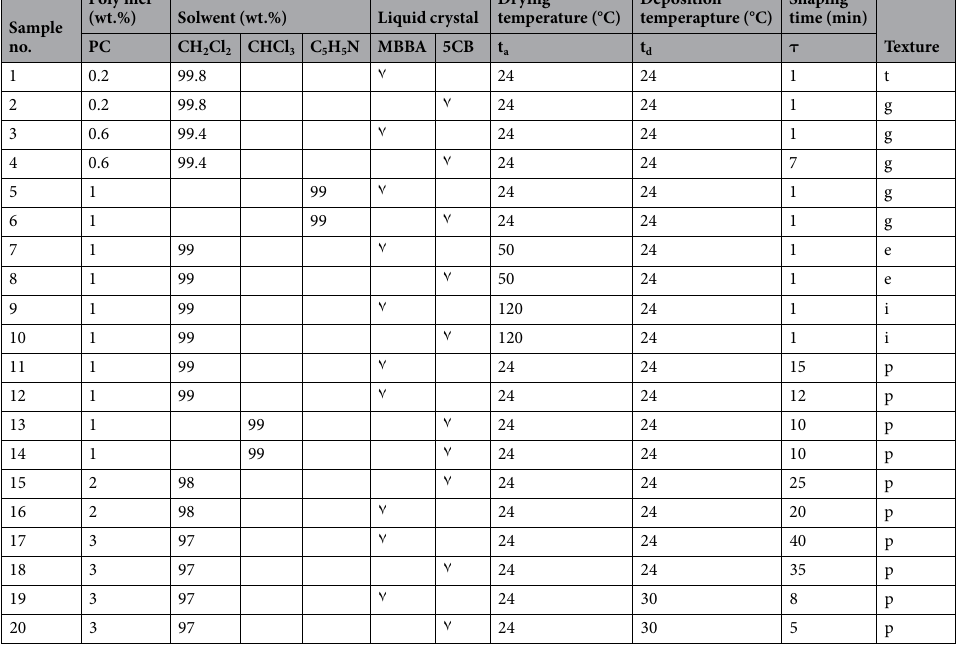
centrations and temperature t d of LC deposition onto the polymer film. At PC concentrations of up to 1 wt.%, the entire domain ensemble forms for τ ≈ 10–15 min at t a = 24 °C and t d = 24 °C and the average domain size attains d ≈ 70–150 µ m (Fig. 3). An increase in the PC concentration to 3 wt.% leads to an increase in the growth time to τ ≈ 30–40 min and in the domain size to d ≈ 150–200 µ m. The dependence of the domain size on the PC concen- tration is caused by the physicochemical processes occurring at the PC/LC interface. Owing to the extinction, the nematic pulls the residual solvent from the polymer film to its boundary, where the mobility of polymer chains increases and the interaction between PC macromolecules and nematic molecules is intensified. The residual solvent concentration in the PC film determines the frequency of formation of nuclei and their growth slows down when domains touch one another. At the high (over 3 wt.%) polymer concentrations, domains coarsen ( d ≈ 200 µ m); however, the low mobility of polymer chains leads to nonhomogeneous filling of the polymer film surface; i.e., the polymer material appears insufficient to form a high-quality polygonal nematic texture. An individual domain of polygonal texture can be observed in crossed polarizers as a region with double extinction bands. The domain is divided in two equal or unequal parts by a disclination line passing through its center, which is almost straight along the domain radius. At a certain position of the polarizers, the disclination lines can be seen as thin dark lines ( 1 in Fig. 2(d)) or broad bright lines ( 2 in Fig. 2(d)). Under synchronous rota- tion of crossed polarizers, the thin dark lines broaden to b ~ 10 µ m and brighten. If, during the polygon texture formation, we cover the PC film by a glass plate rubbed to provide the planar orientation in the LC layer, the dis- clination lines will tend to align perpendicular to the rubbing direction. The degree of their alignment depends on nematic layer thickness ξ . At ξ ≈ 10 µ m, only a small part of the disclination lines will be aligned, while at ξ ≈ 2 µ m, all the lines will be oriented (Fig. 2(e,f)). Their orientation is similar to that obtained in magnetic field H * applied along the PC film during the structure formation. At H * = 2.5 kOe, only a part of the disclination lines will be aligned. At H * = 20 kOe, we can observe the total alignment of the disclination lines perpendicular to H * (Fig. 2(g,h). In both cases, the director n of the bulk LC layer tends to align perpendicular to the disclination lines.